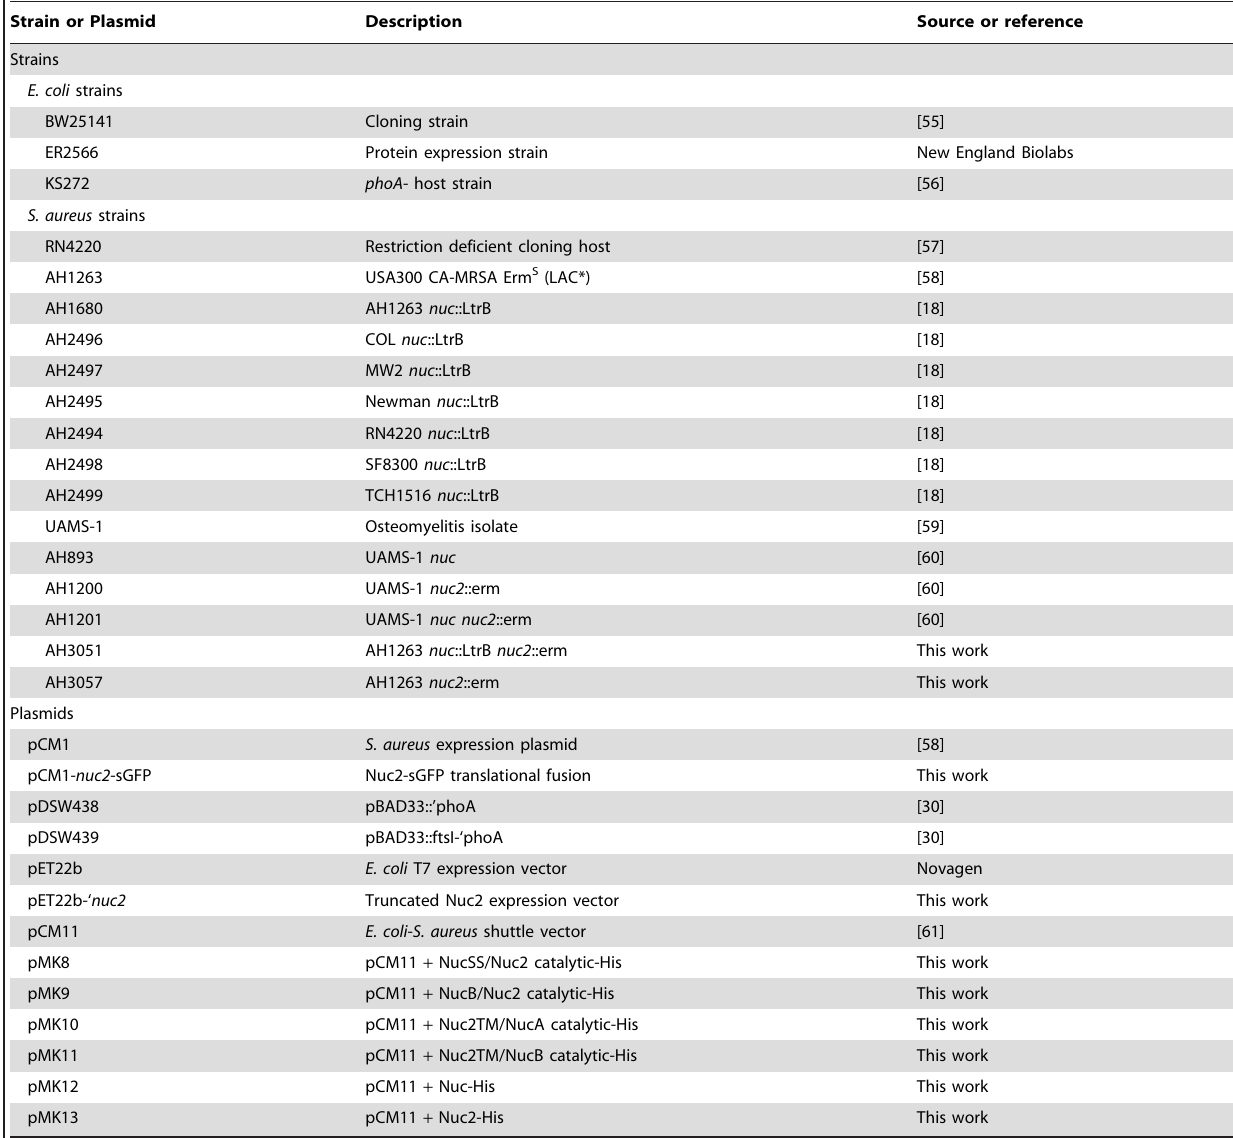
Table 1. Bacterial strains and